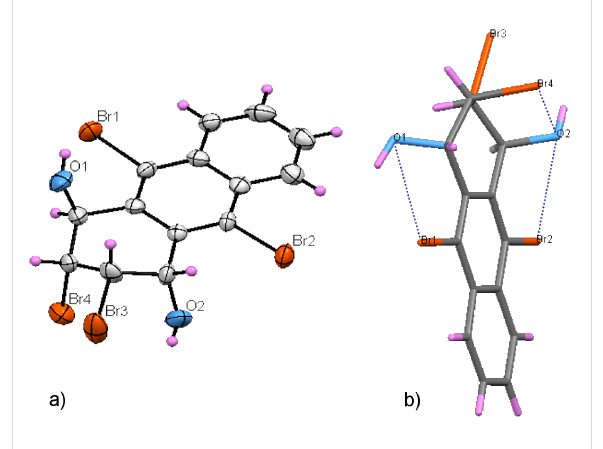
Figure 2: a) X-ray ORTEP plot of compound 17 . Displacement ellip- soids are shown at 40% probability level. b) X-ray structure of 17 showing intramolecular